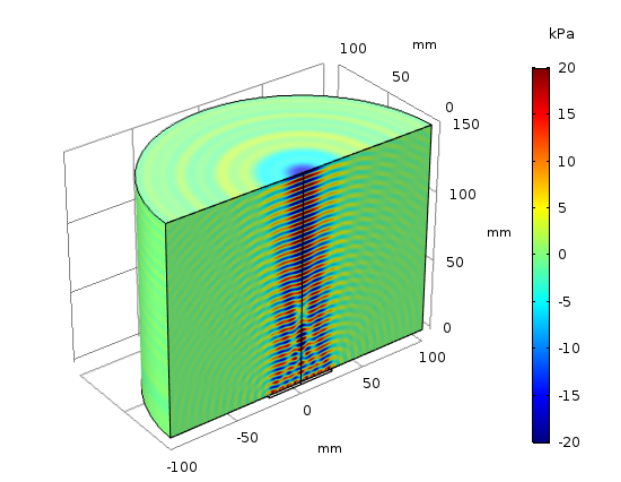
Figure 4. Acoustic pressure distribution on the vertical cross-section of the barrier.